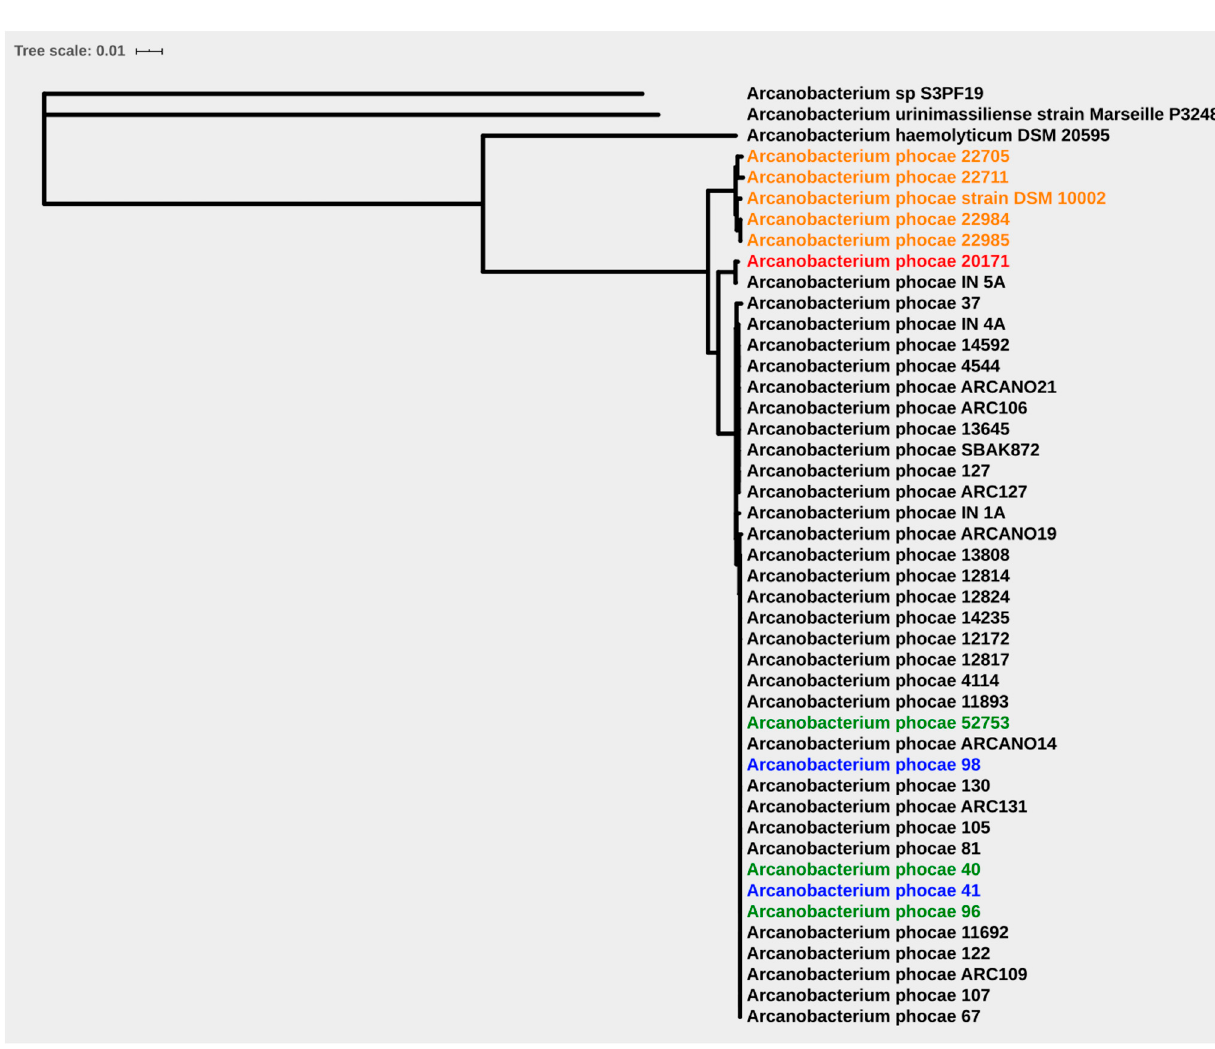
Figure 1. Phylogenetic tree based on core genome (Mink in black color, Finn-raccoon in green, Bluefox in blue, seal in orange and otter in red) (1296 genes).